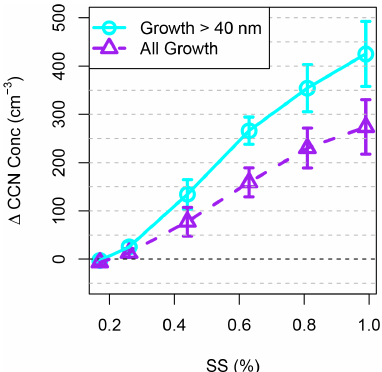
Figure 6. Twomey parameterization for the entire study (black) and the three legs (red, blue, and Figure 5. The increase in CCN concentration during growth > 40nm (cyan) and all growth (purple) times compared with back- ground times at different SS. The error bars show the 95% confi- dence interval. Table 3. Calculated Twomey parameters. All Baffin Bay Nares Strait Resolute Bay C 455 337 172 0.81